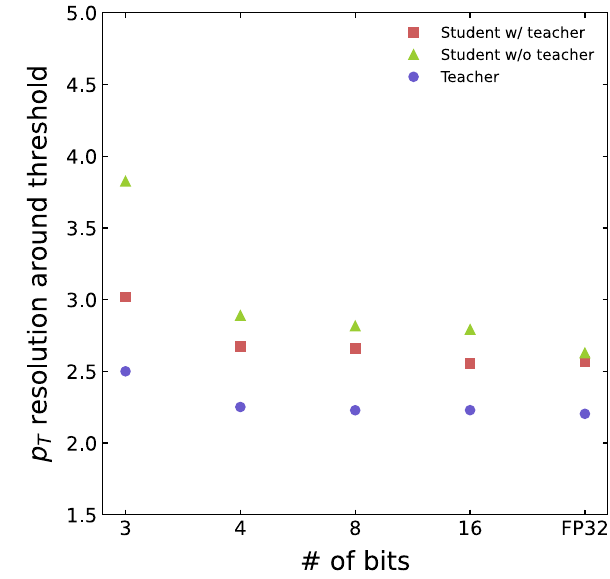
Fig. 12 σ p computed in a true p T interval around threshold T ( 7 . 5 GeV < p < 12 . 5 GeV) as a function of the number of bits T per weight. In indigo (circles) the performance of the Teacher model. In light green (triangles) the performance of the Student trained with- out any help from the Teacher. In red (squares) the performance of the Student trained with hints from the Teacher